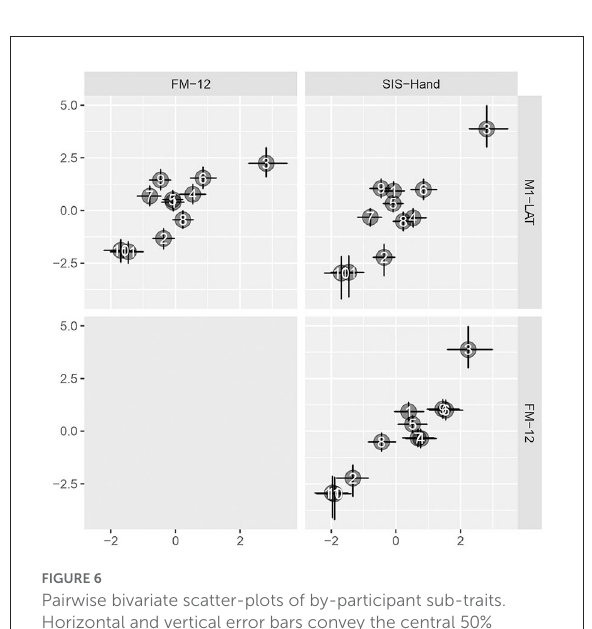
FIGURE6 Pairwise bivariate scatter-plots of by-participant sub-traits. Horizontal and vertical error bars convey the central 50% credible interval (25%ile to 75%ile) on these constructs, crossing at the